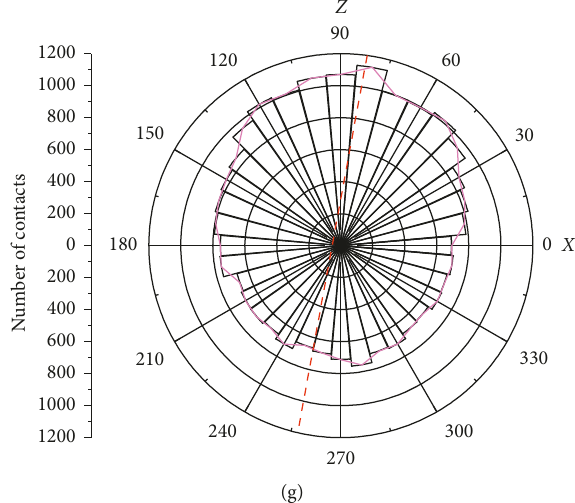
Figure 22: Distribution of contact orientation for SY_2_15 on X - Z plane (the red dotted line is the major axis of the distribution): (a) point A; (b) point B; (c) point C; (d) point D; (e) point E; (f) point F; (g) point G.